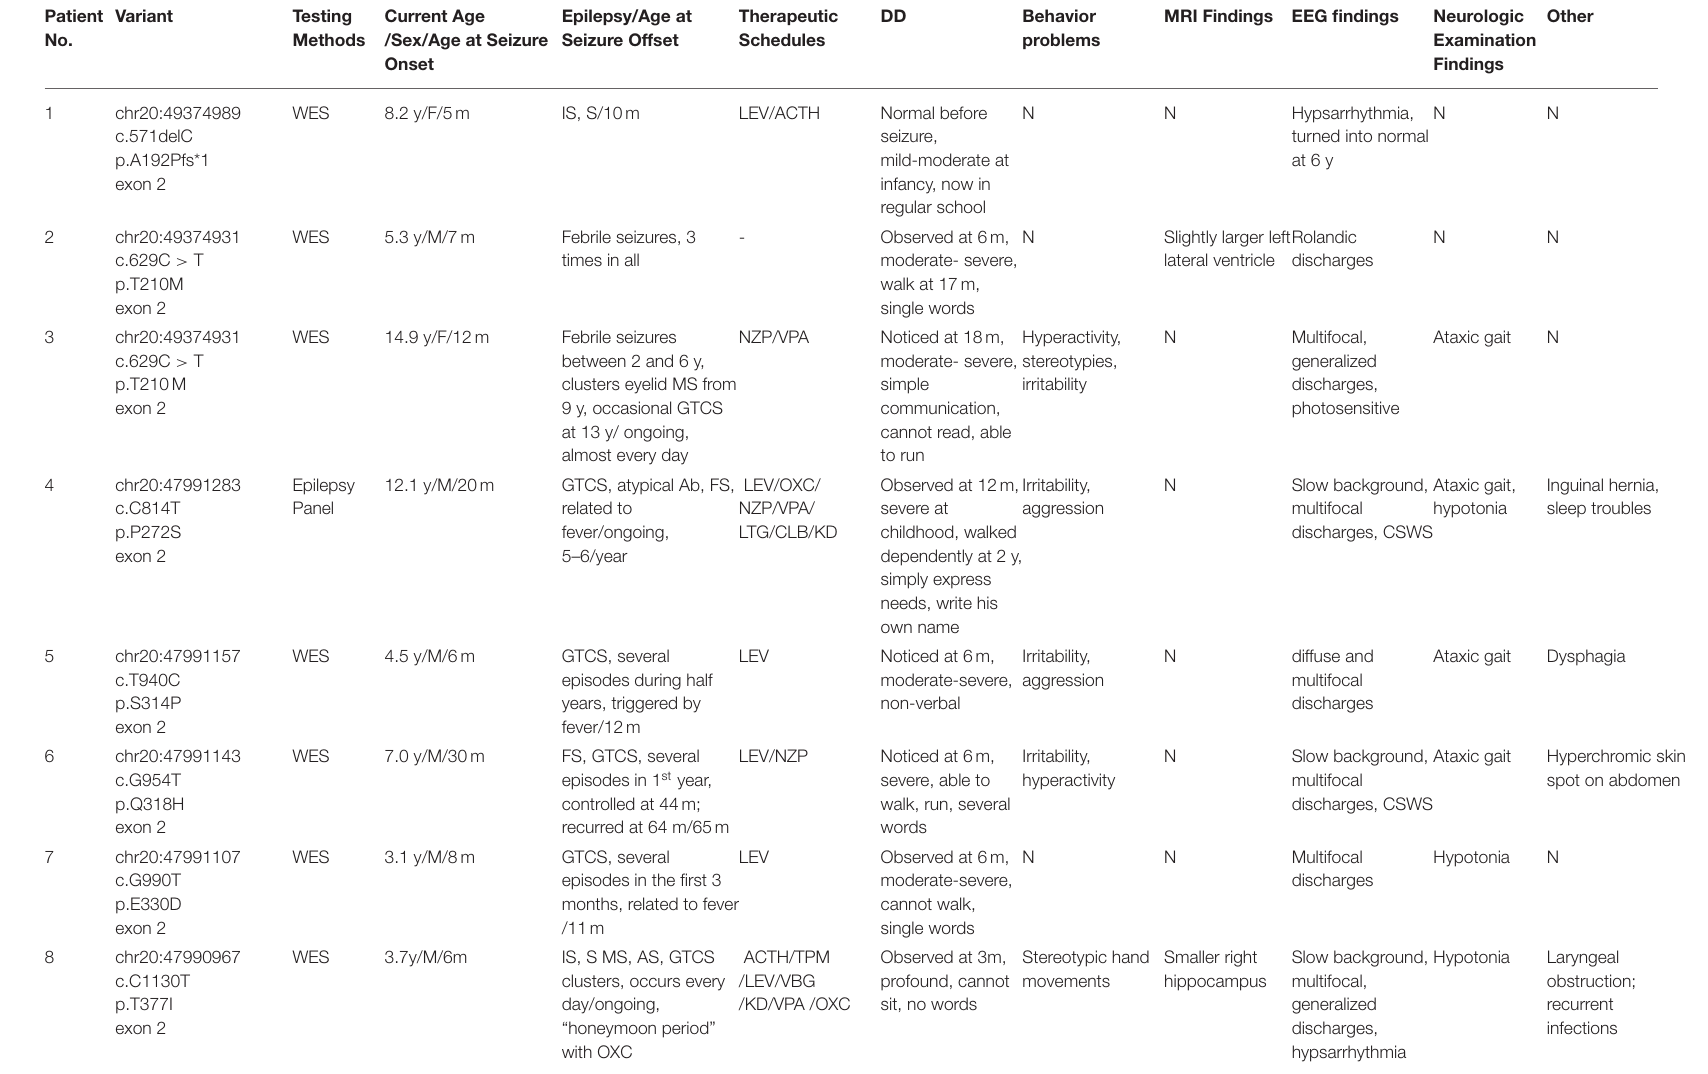
TABLE 1 | Clinical characteristics and genetic information of patients with KCNB1 related-neurodevelopmental disorder reported in our cohort. Patient